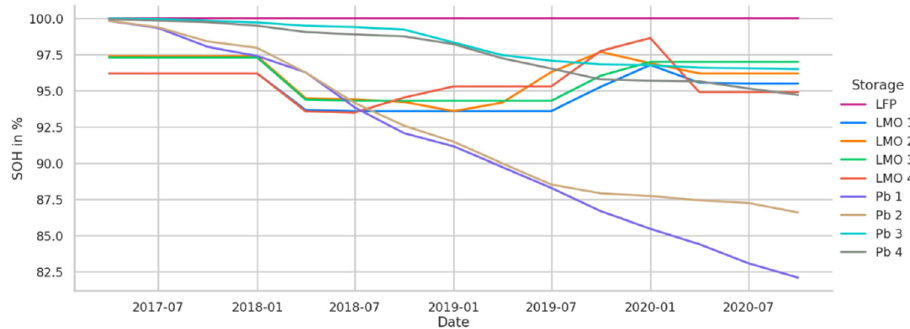
Figure 12. Development of the SOH transmitted by the BMS for the different battery units.